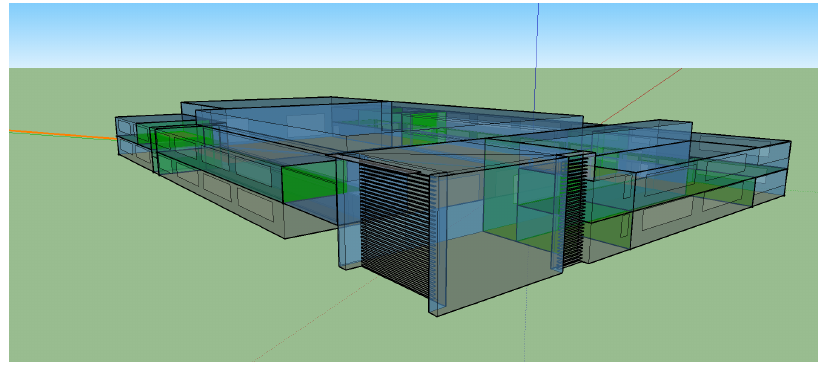
Figure 3. The Leaf Lab 3D simulation